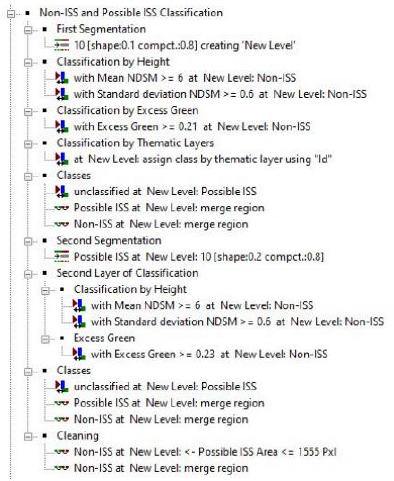
Figure 3. Detailed non-ISS removal rule-set.